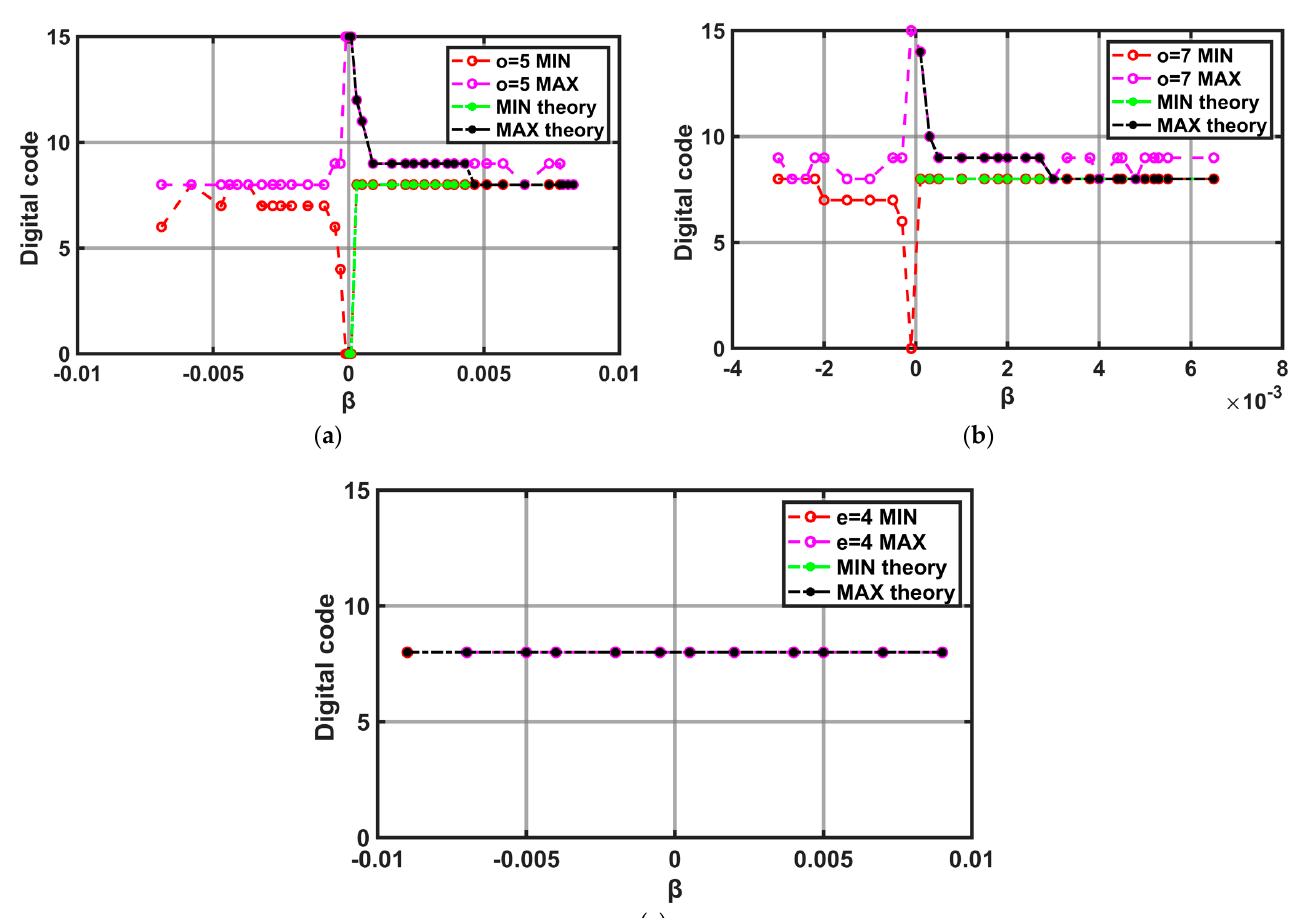
Figure 5. ( a ) Maximum and minimum digital code of the Verilog simulations and theoretical results in an odd-denominator condition (o = 5). ( b ) Maximum and minimum digital code of the Verilog simulations and theoretical results when o = 7. ( c ) Maximum and minimum digital code of the Verilog simulations and theoretical results in an even-denominator condition (e = 4).